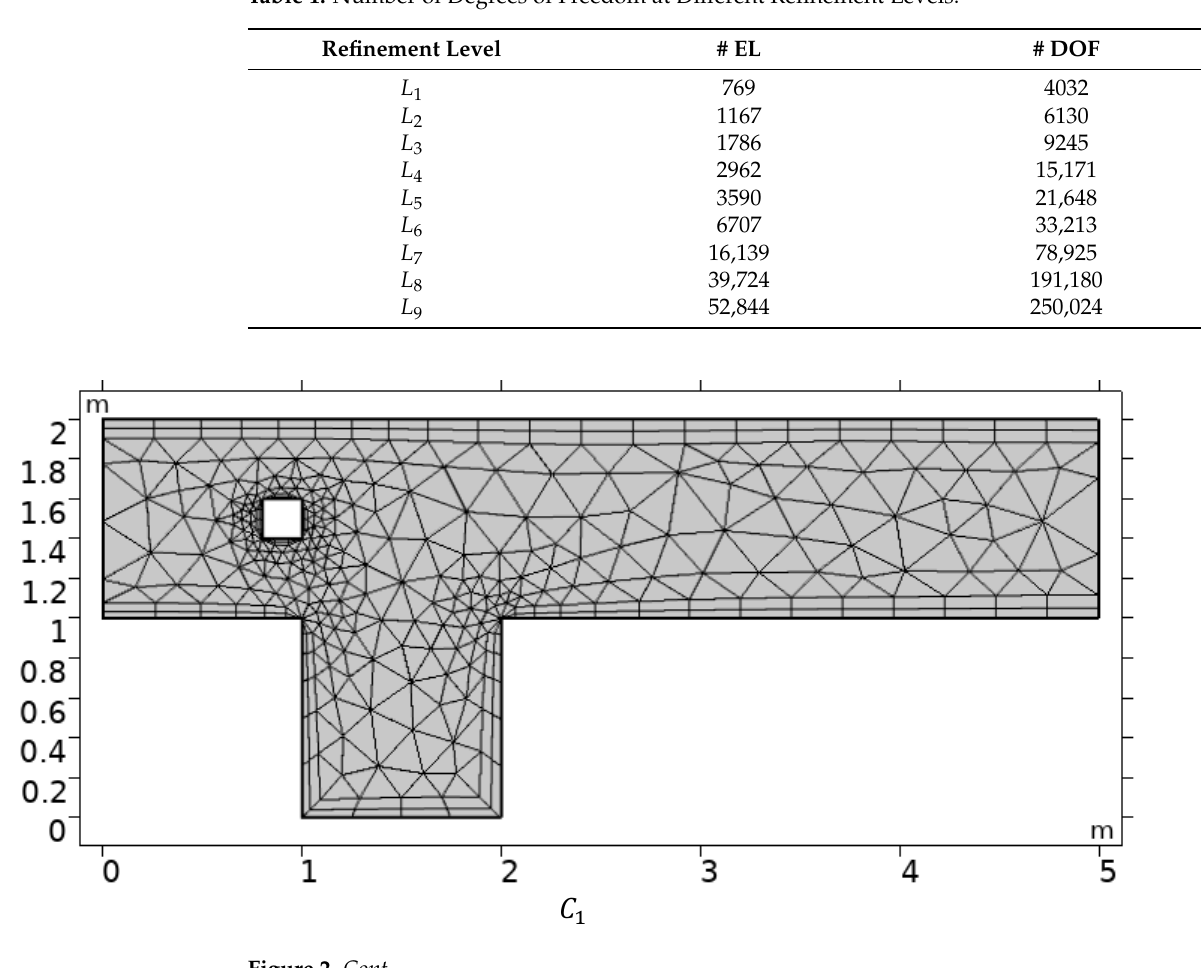
Figure 1. Physical configuration of the problem. Table 1. Number of Degrees of Freedom at Different Refinement Levels.